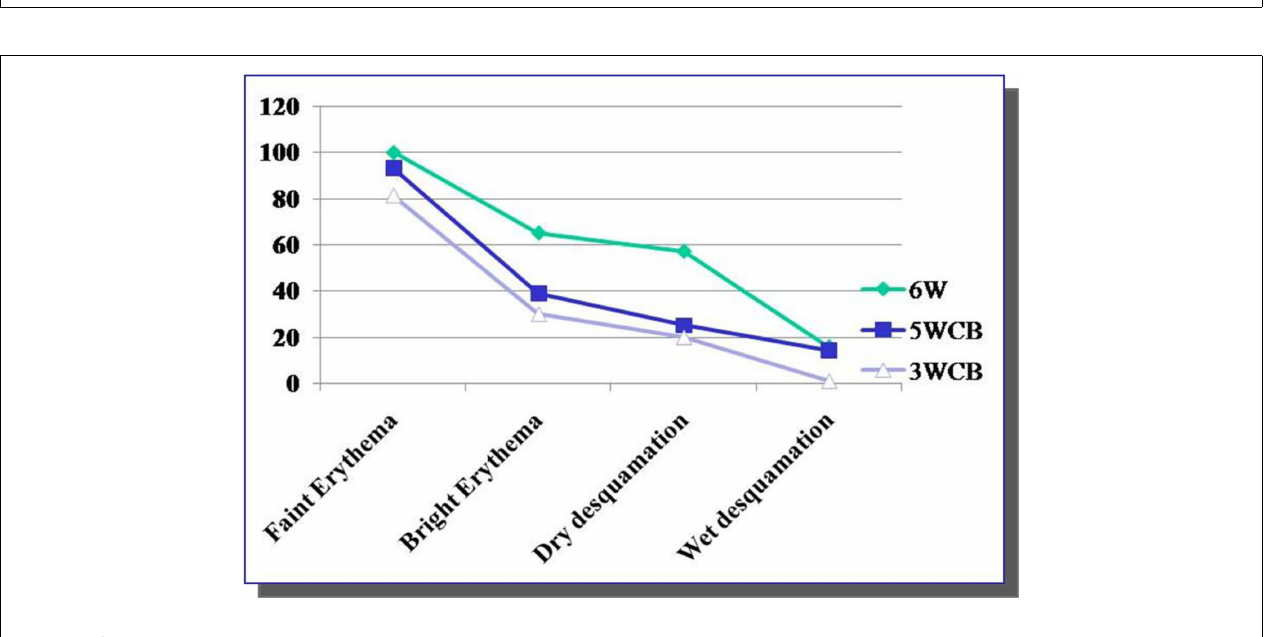
FIGURE 3 | Kinetics of Grade 2 and 3 acute toxicities. Grade 2 toxicity (brisk erythema) was noticed at week 3 in 70% of patients in 5wCB and 6wSB schedules and in only 11% of the patients treated